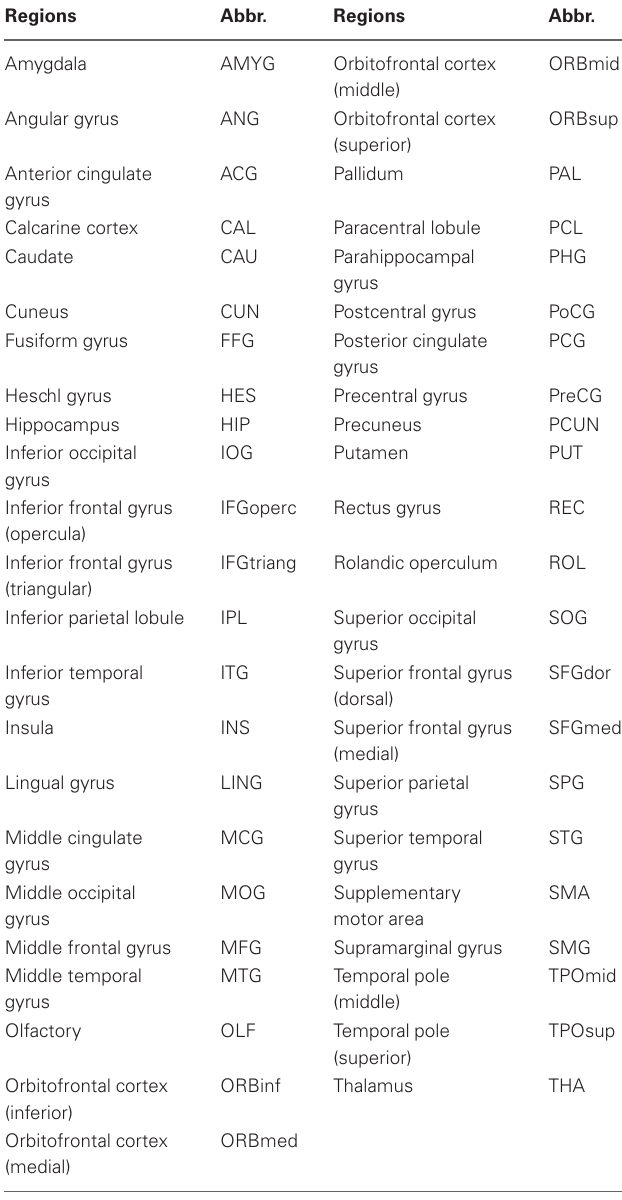
Table 1 | The names and abbreviations of the regions of interest